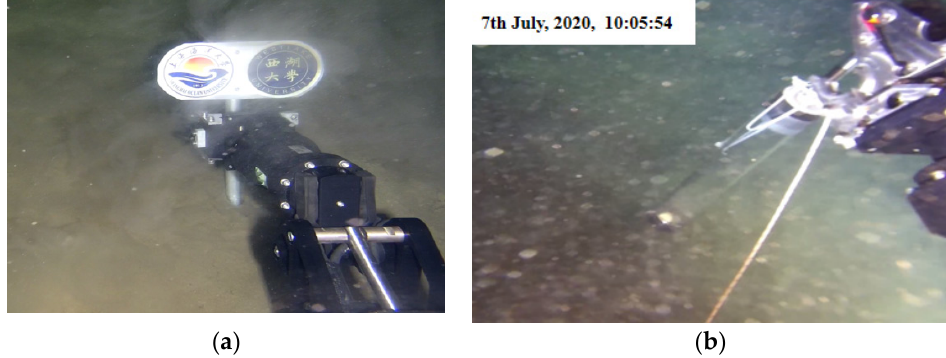
Figure 25. ( a ) Placement of the marker at 3577 m water depth; ( b ) sediment sampling.